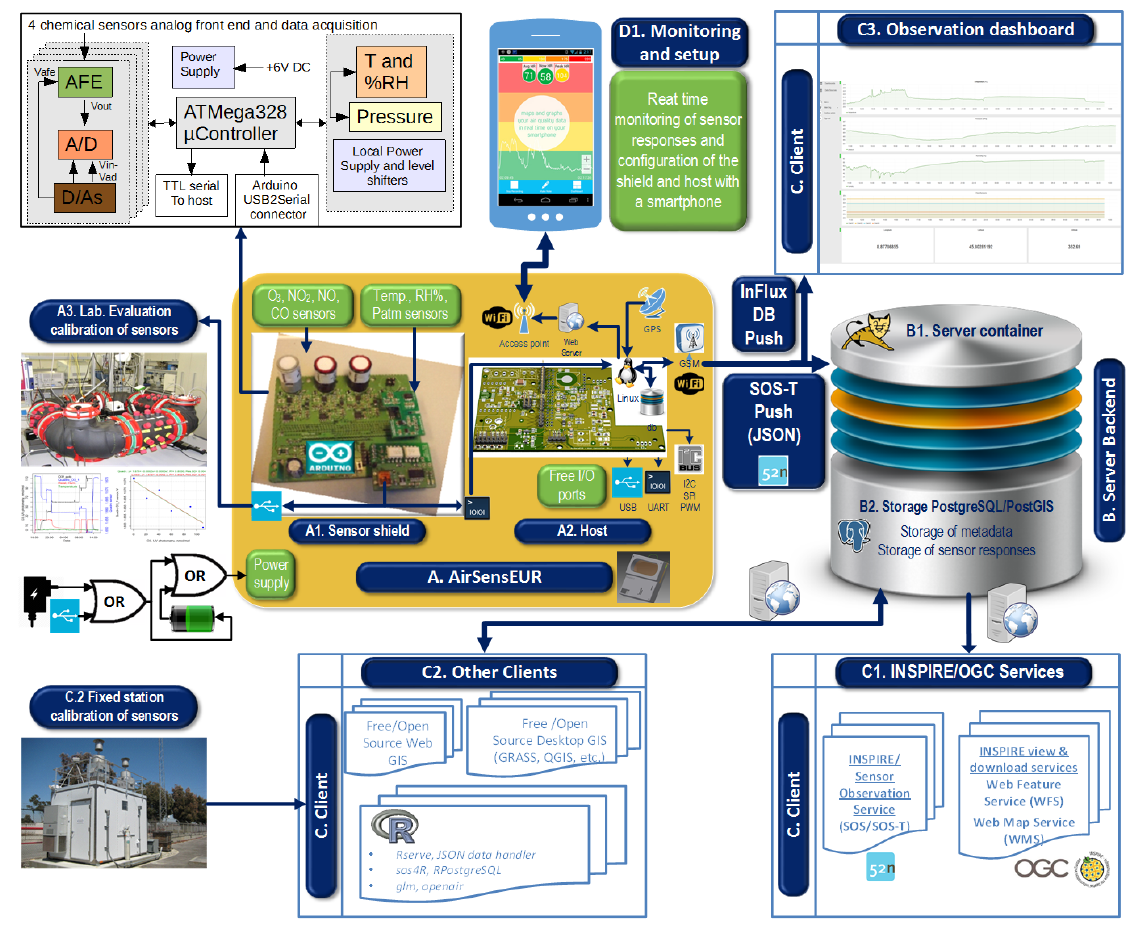
Figure 2. Architecture of